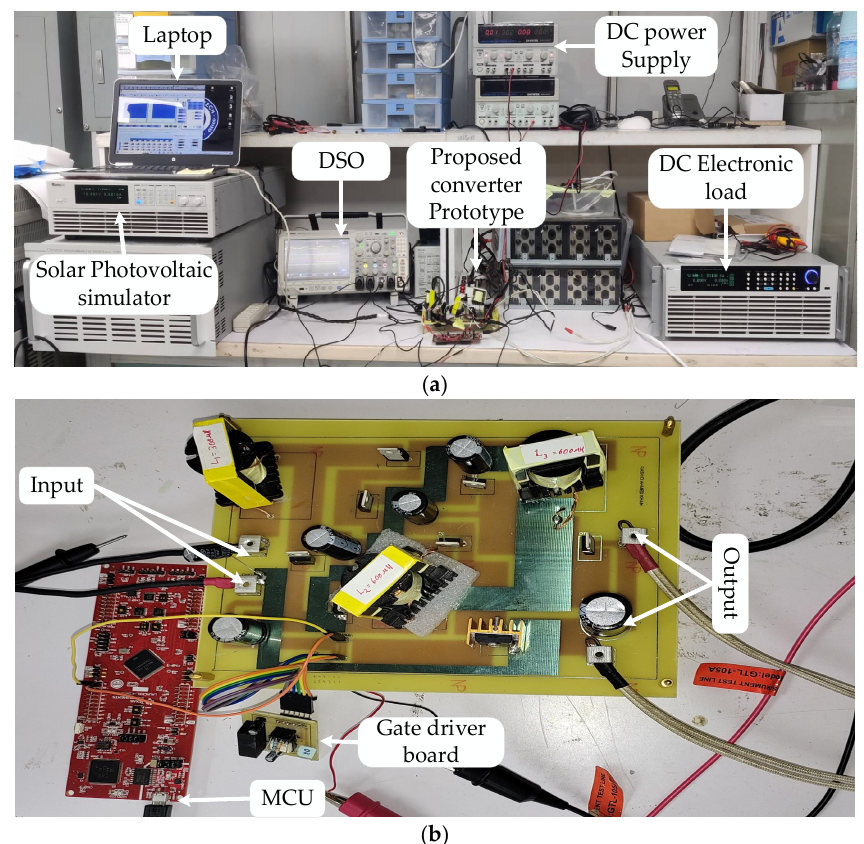
Figure 15. ( a ) Experimental testbed of the proposed HGVSU converter in a power and energy laboratory, and ( b ) hardware prototype of the proposed HGVSU converter.